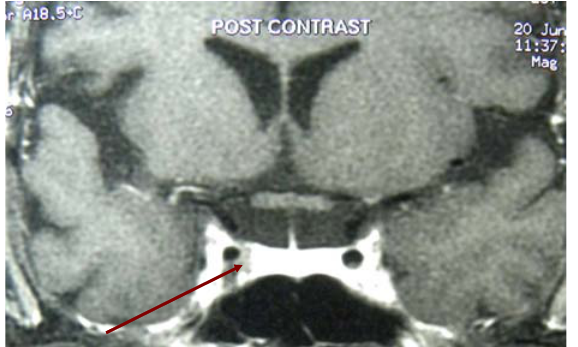
Figure 1. MRI pituitary – arrow showing the micro